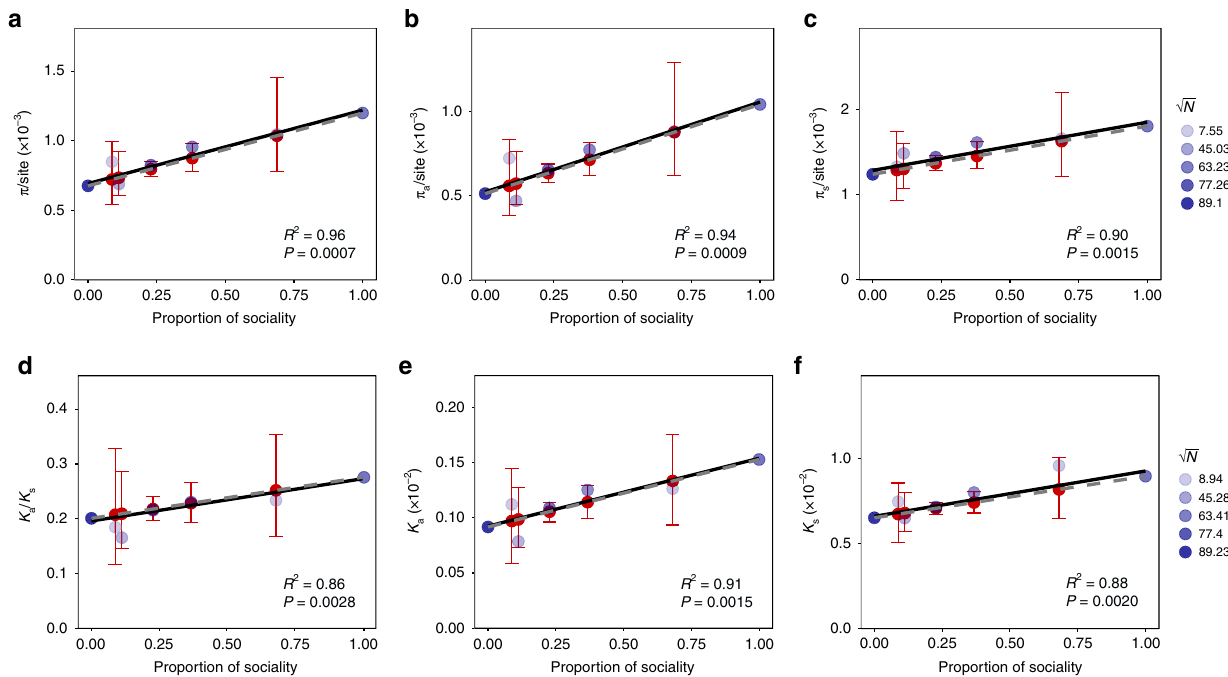
Fig. 4 The impact of Red King processes on polymorphism and divergence. The top row of panels shows the relationship between nucleotide diversity in social genes at the full CDS a , nonsynonymous b , and synonymous sites c as a function of the proportion on conditionally expressed (sociality) genes within that group. Similarly, the bottom row of panels shows the relationship between the rates of nonsynonymous e , synonymous substitutions f , and the rate of protein evolution d in groups of genes as a function of the proportion of sociality genes in each group. In each panel the red points indicate the expected value for a group and the red error bars the 95% con fi dence interval (both calculated from a set of 10,000 permutations). The blue points indicate the observed values for each group of genes, with the darkness of the point being determined by the sample size (based on indicates to the expected value of each parameter predicted from the sociality and non-sociality genes. The solid line corresponds to the best fi t line from a ffiffiffiffi p N weighted regression (where weightings are ) fi tted to the observed values. Source data are provided as a Source Data fi